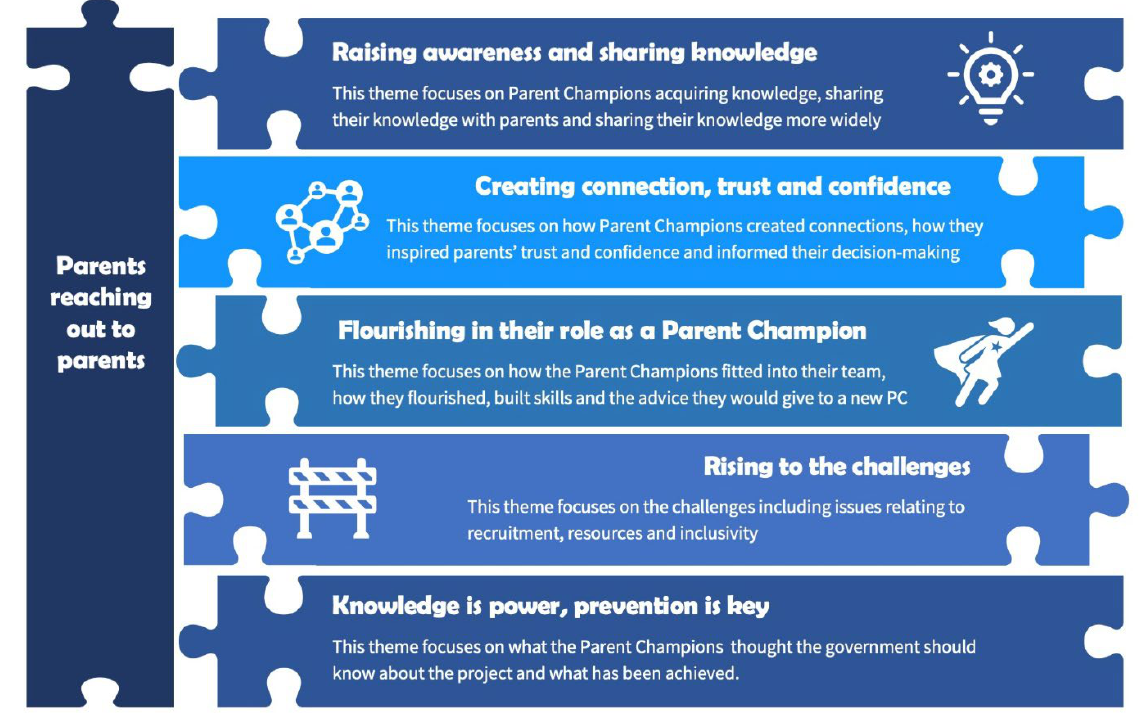
Figure 1. Overarching and